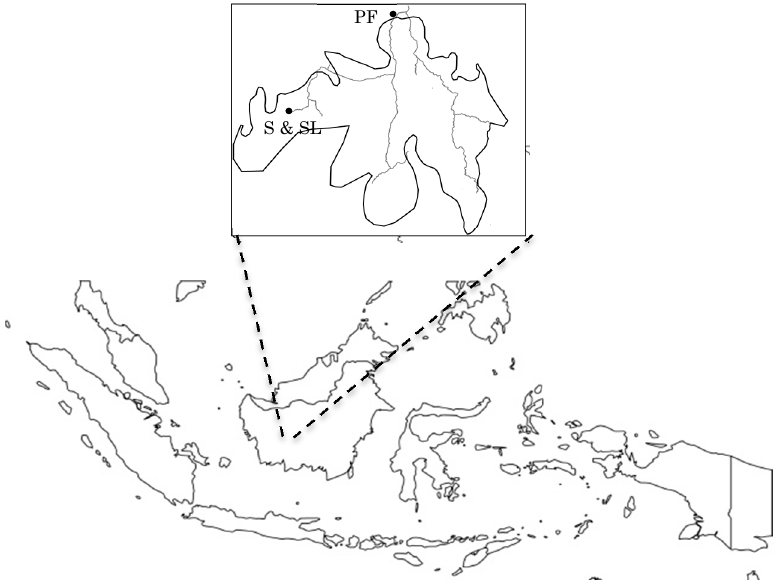
Figure 1. Study area and the location of primary forest (PF), selectively logged (S) and selectively logged and line planted (SL) sites where hemispherical photography was conducted.